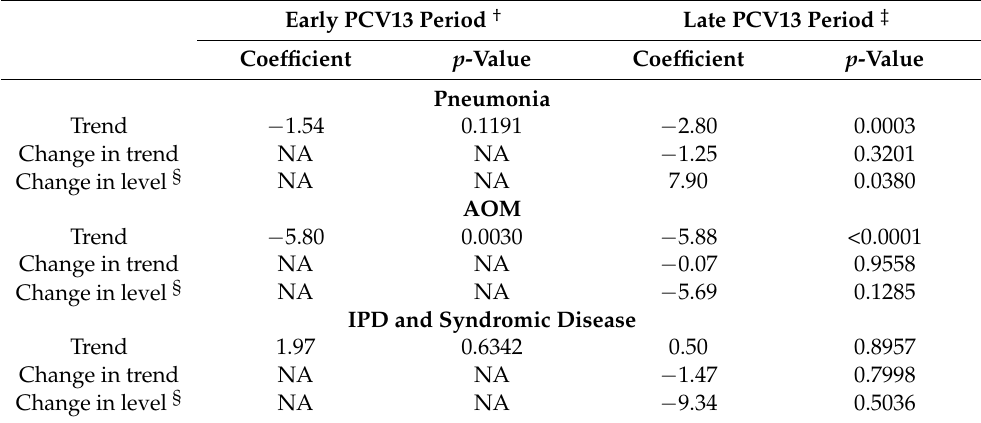
Table 4. ITS analysis of annual IR of pneumonia, AOM, and IPD and syndromic diseases for children < 15 years of